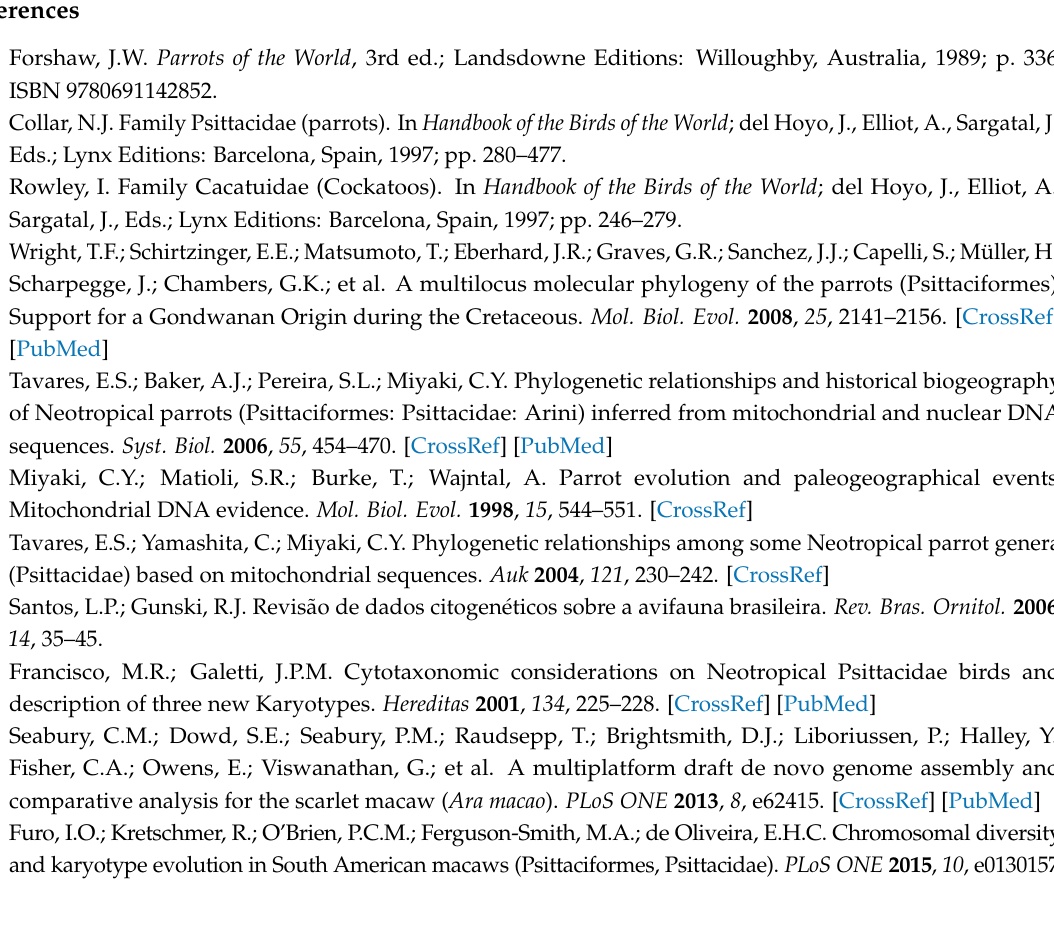
Supplementary Materials: The following are available online at www.mdpi.com/xxx/s1, Table S1: List of specimens collected in the present study, Table S2: Correspondence between syntenic groups of Psittaciformes species analyzed by FISH and the putative ancestral avian karyotype (PAK) and Gallus gallus chromosomes (GGA), Table S3: Correspondence between syntenic groups of Psittaciformes species analyzed by FISH with Gallus gallus probes, Table S4: Comparison and morphological classification of macrochromosome pairs of 31 species belonging to fourteen genus of Neotropical Psittacidae. A—acrocentric, T—telocentric, SM—submetacentric, MT—metacentric. ( − ) not described. (*) polymorphic